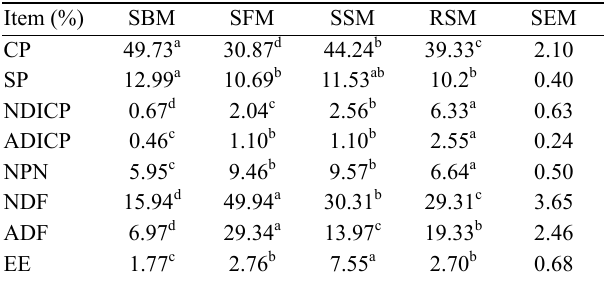
Table 4. Amino acid composition of the SBM, SFM, SSM